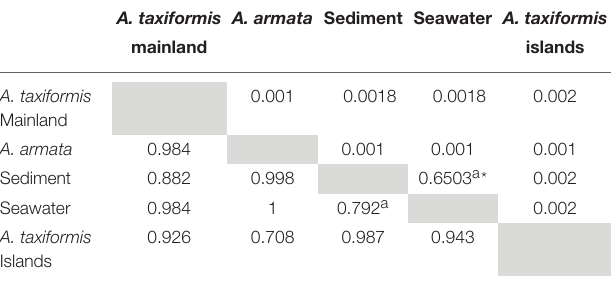
P-values are represented on the top of the matrix and R values on the bottom. H 0 : there are no differences in the distribution of OTUs between the members of the various groups, H 0 rejected if: p < 0.05 . R-values vary between 0 and 1. Large positive R (up to 1) signifies dissimilarity between groups. * There are no significant differences between the groups. a Significance (p) value is > 0.05 but R-value shows high separation between levels of